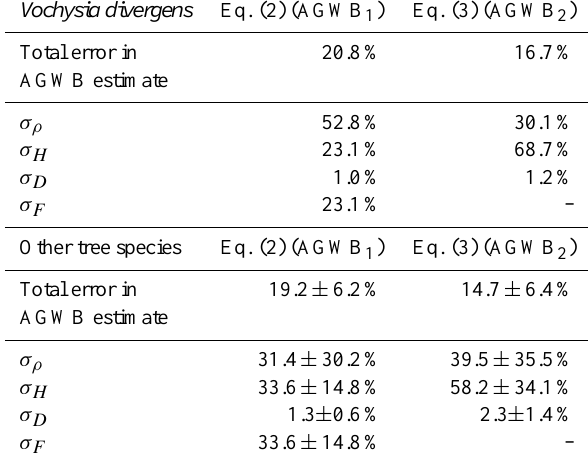
Table 4. Propagation of assumed measurement errors for convert- ing forest inventory data ( D , H , ρ , F) into estimates of AGWB using Eqs. (2) and (3) differentiated for trees of V. divergens and other